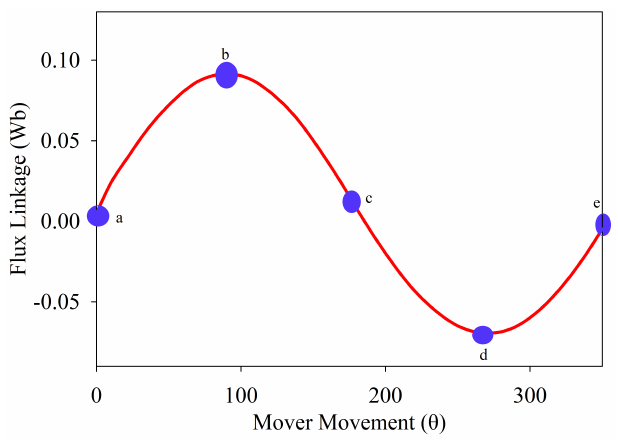
Figure 4. No-load flux